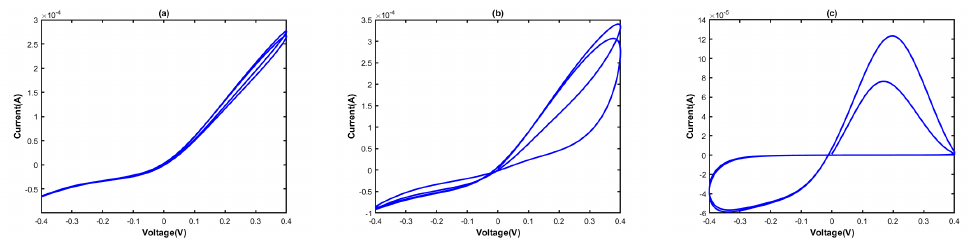
Figure 13. Hysteresis loops for different amplitudes of source voltages, for 16 nm: ( a ) − 0.6 V, ( b ) − 0.7 V, and ( c ) − 0.8